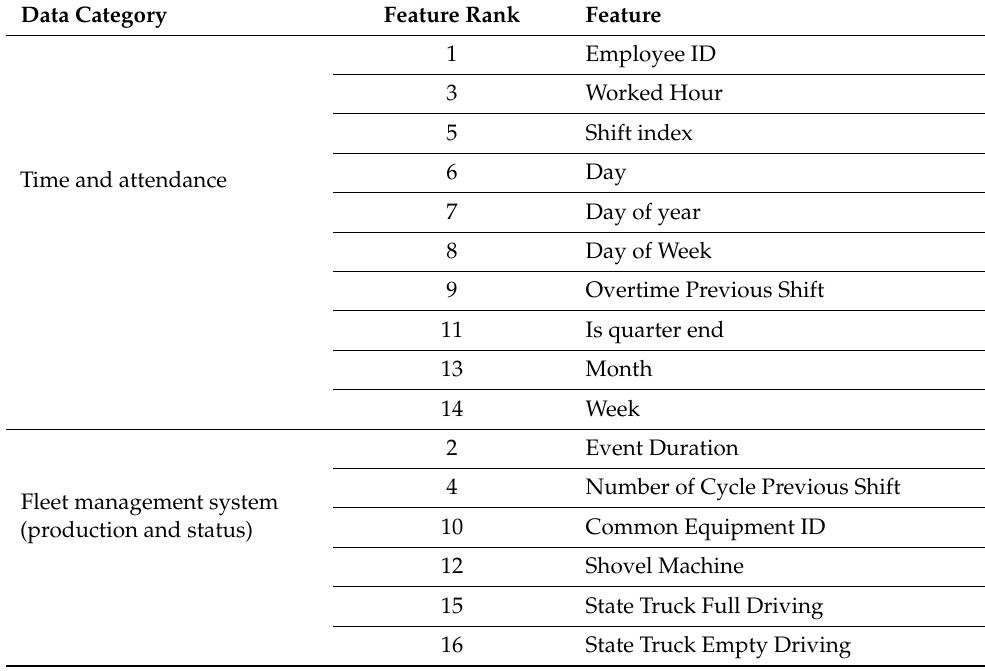
Table 8. Top features by data